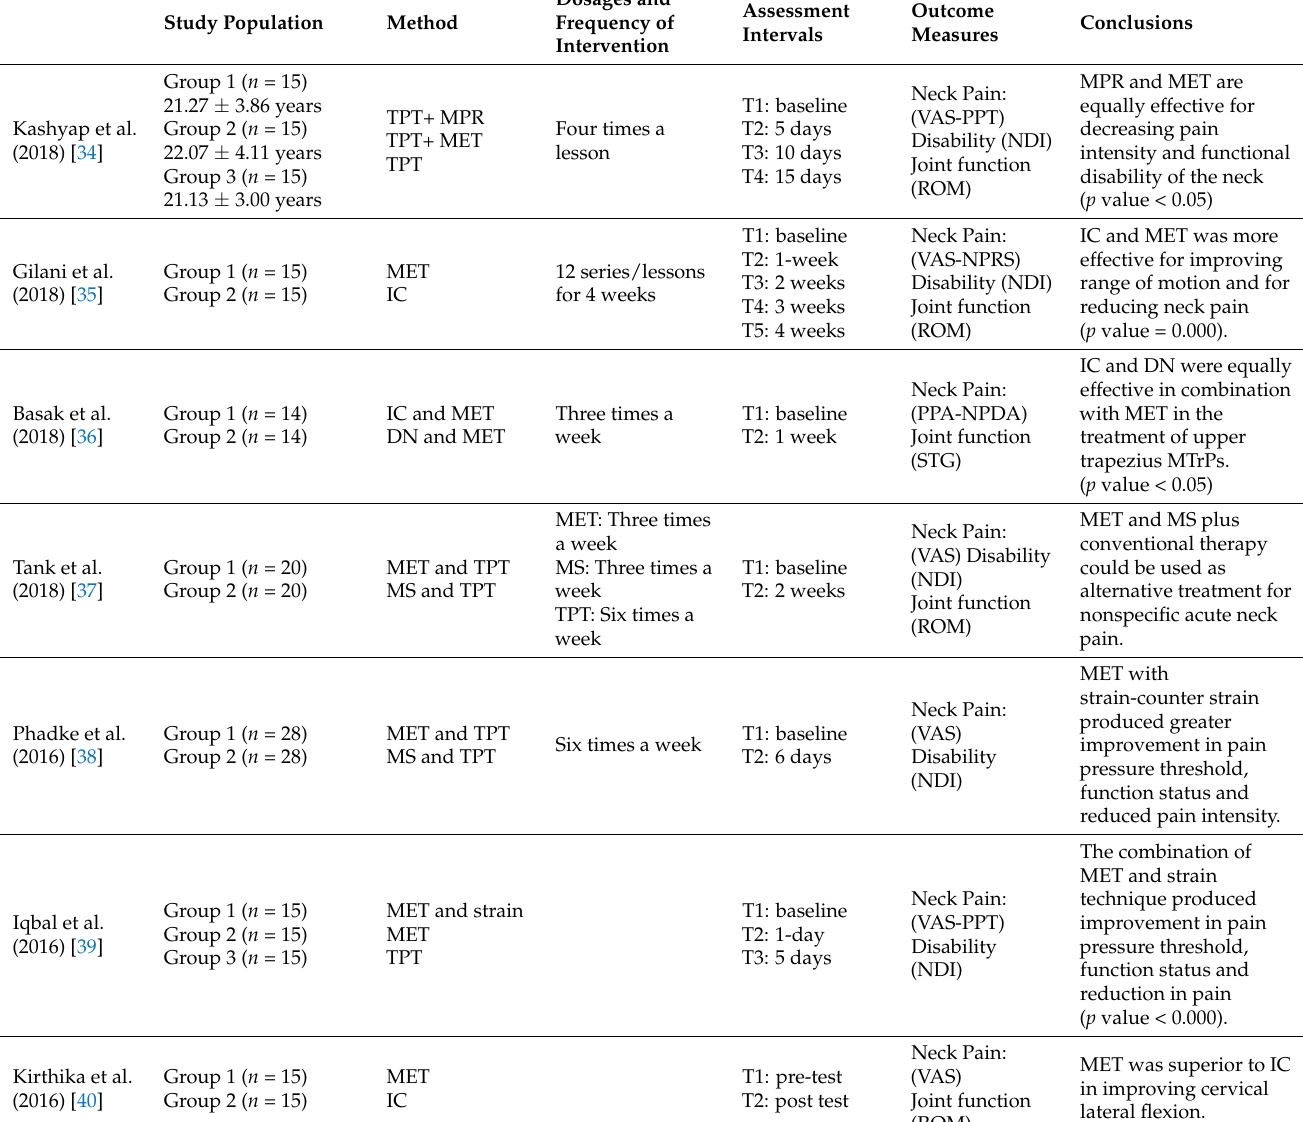
Table 2. Description of intervention in non-specific acute neck